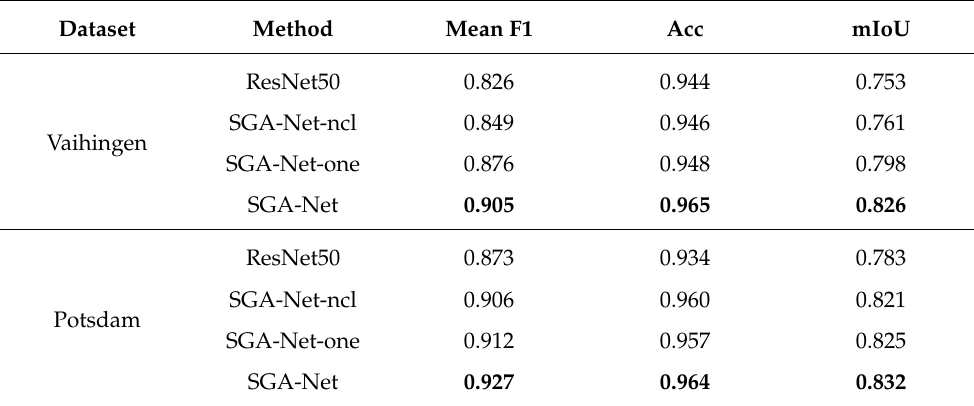
Table 3. The ablation study about SGA-Net.